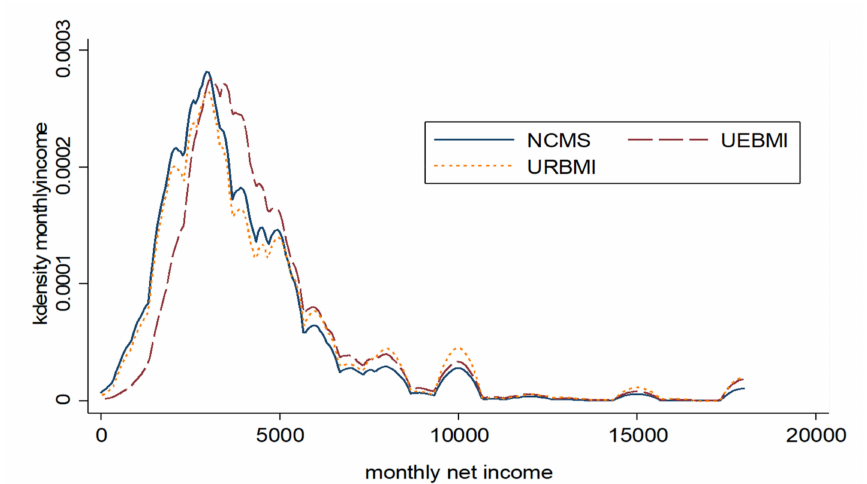
Figure 1. Estimated Kernel density of monthly net income distribution of agricultural migrants.